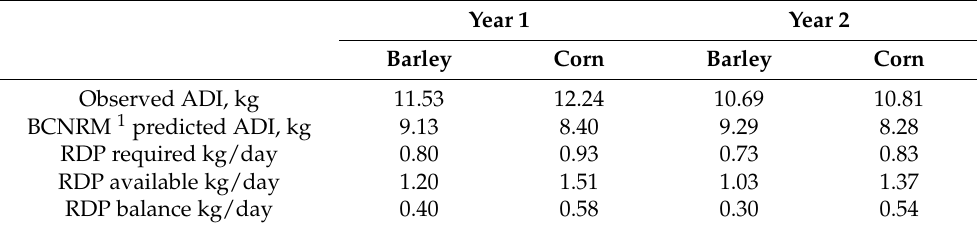
Table 5. Observed average daily intake (ADI) and BCNRM predicted ADI, rumen degradable protein (RDP) requirements, available RDP and RDP balance for steers consuming finishing diets containing corn or Hockett barley as basal grains at the Northern Agricultural Research Center. Year 1 Year 2 Barley Corn Barley Corn Observed ADI, kg 11.53 12.24 10.69 10.81 BCNRM 1 predicted ADI, kg 9.13 8.40 9.29 8.28 RDP required kg/day 0.80 0.93 0.73 0.83 RDP available kg/day 1.20